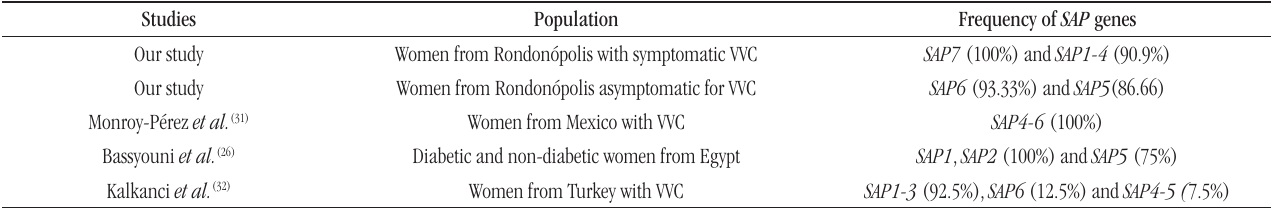
taBLE 4 − Frequency of SAP genes in different